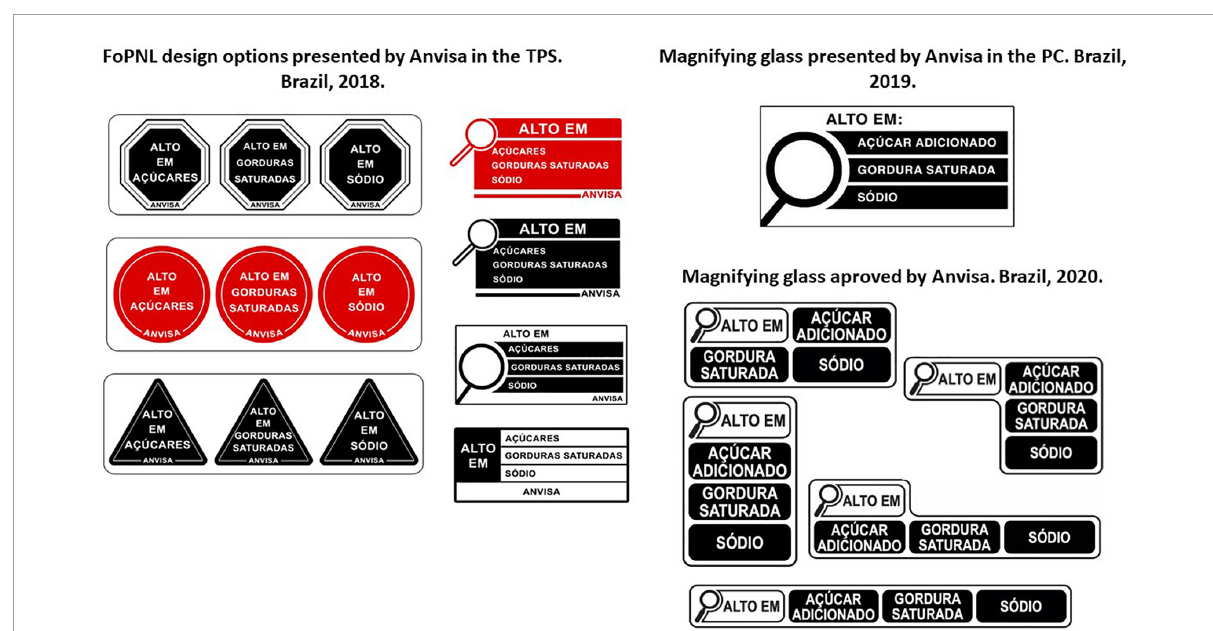
FIGURE2 Different FoPNL models proposed by Anvisa during the regulatory process. (A) FoPNL design options presented by Anvisa in the TPS. Brazil, 2018. (B) Magnifying glass presented by Anvisa in the CP. Brazil, 2019. (C) Magnifying glass approved by Anvisa. Brazil. 2020. Source: Anvisa. FoPNL, front-of-package nutrition labeling; Anvisa, Brazilian Health Surveillance Agency; TPS, Public Collection of Information; PC, public